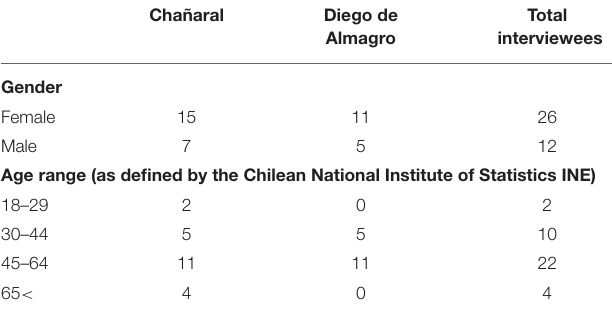
TABLE 1 | Categorization of the interviewees by gender, age and